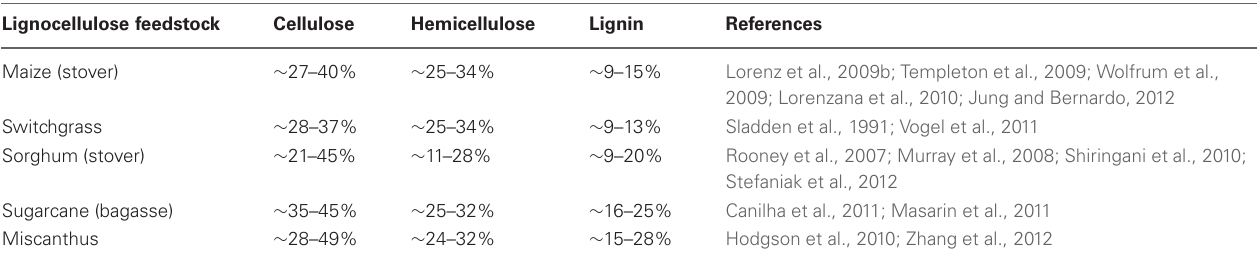
Table 2 | Variation in cell wall compositions of promising C4 energy grasses a